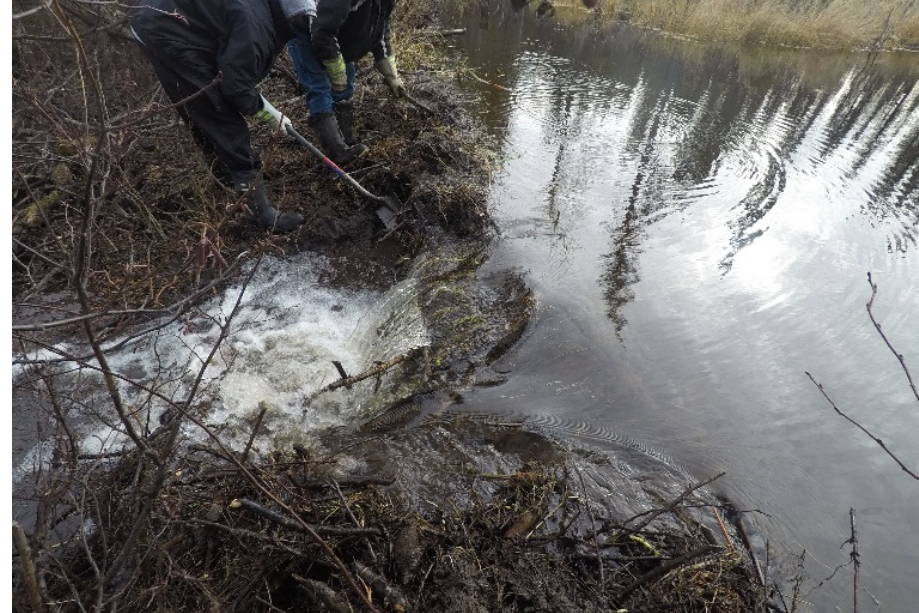
Figure 7. A stream which was one blocked by a beaver dam being cleared by an Elder and youth.